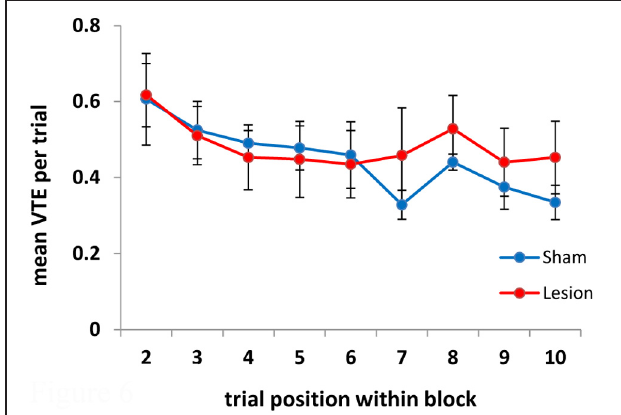
FIGURE 6 | VTEs as a function of trial within each block. VTEs decreased over trials within each block. Note that the first trial within each block is not included in this analysis as on the first trial the animals do not know that a given goal box is rewarded until they reach